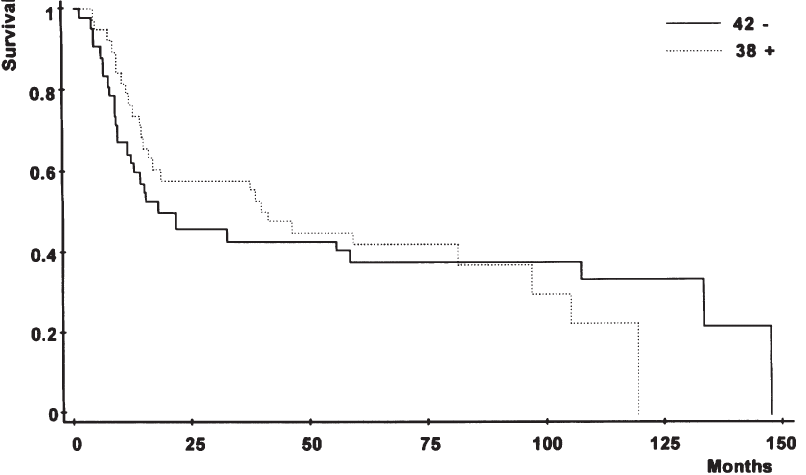
Fig. 4. Crude survival for p53 mutations, including the 17 tumours with the new non random deletion. No difference in crude survival was seen between tumours with and without